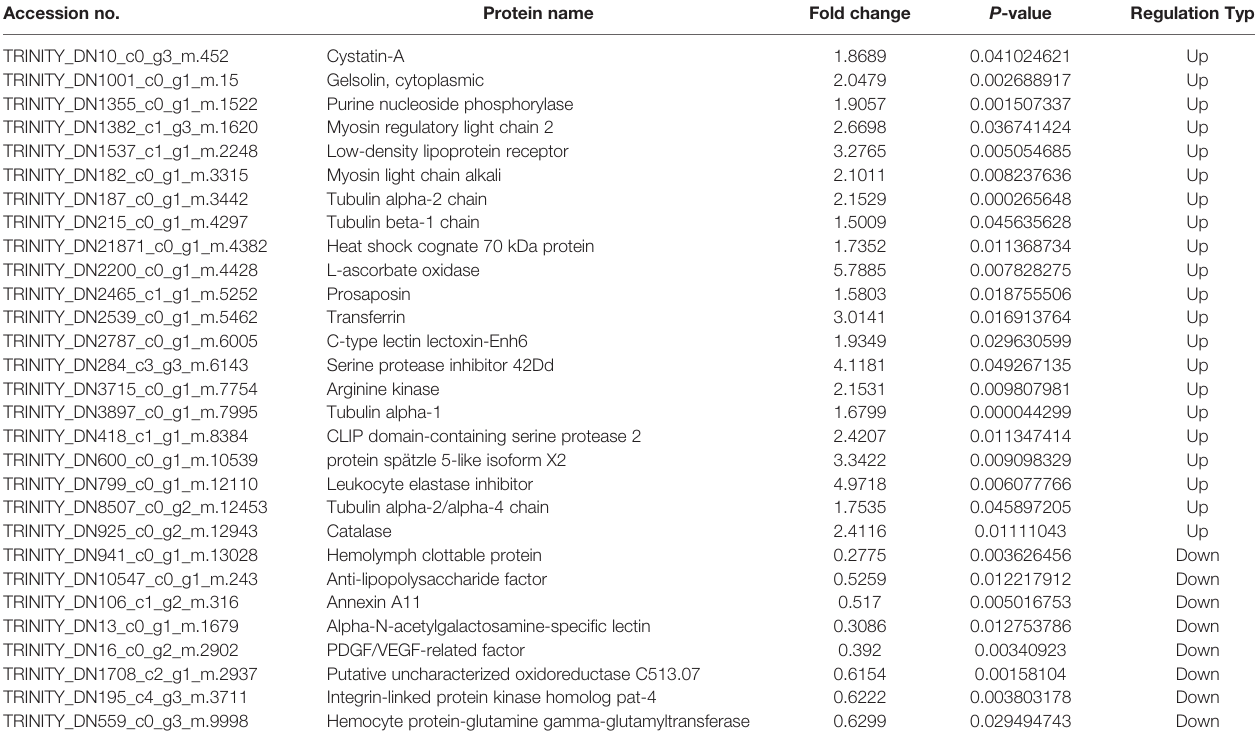
TABLE 1 | Differentially expressed immune-related proteins. Accession no. Protein